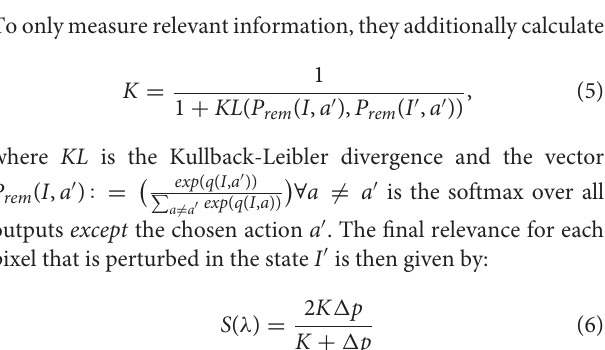
Since the original source does not go into details about the algorithm, we use the tf-explain implementation as reference 2